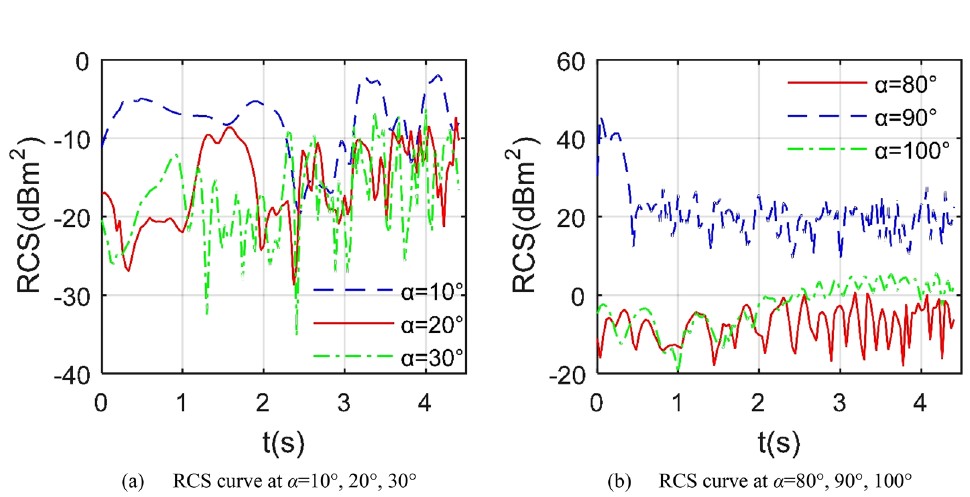
Figure 10. RCS of the aircraft under different azimuths, β = 0°, f RH = 6 GHz, ω m1 = ω m2 = 0.1963 rad/s.